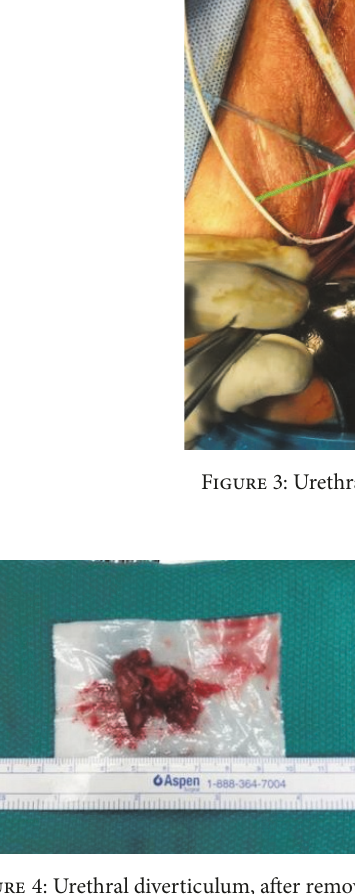
Figure 4: Urethral diverticulum, after